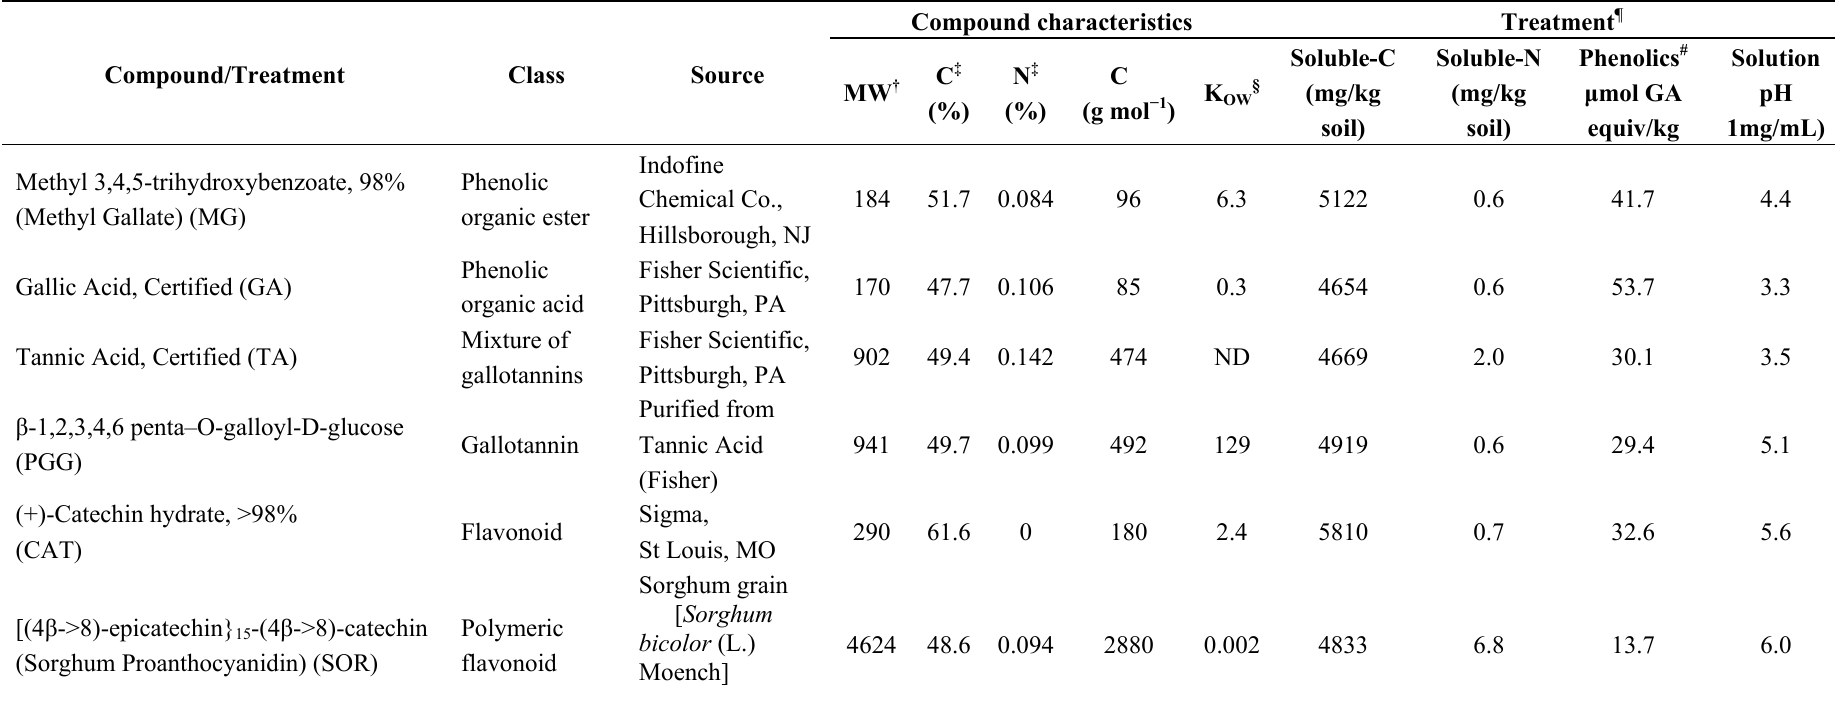
Table 2. Information on the test compounds added to soil from the field studies of amendments to agricultural soil at the Columbia Plateau Conservation Research Center, Pendleton, OR,